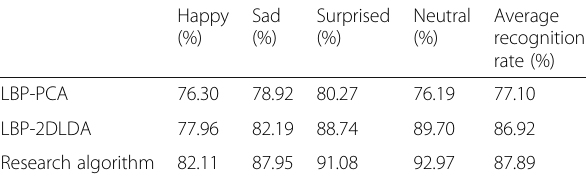
Table 2 Recognition rate of each algorithm in JAFFE face database